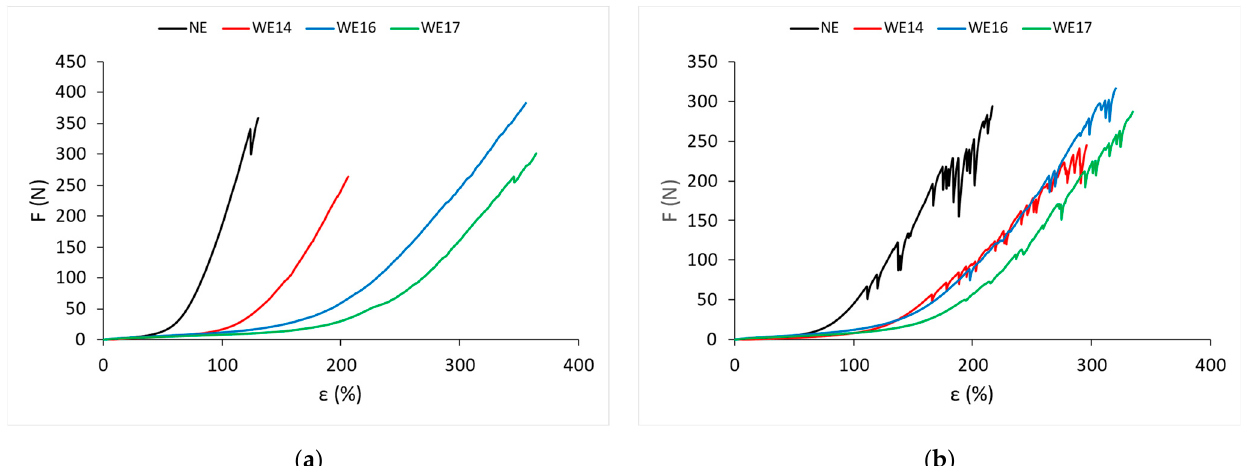
Figure 5. Force–elongation diagrams for knitted fabric samples with polyamide yarn and wrapped elastane yarns: ( a ) wales direction; ( b ) courses direction.